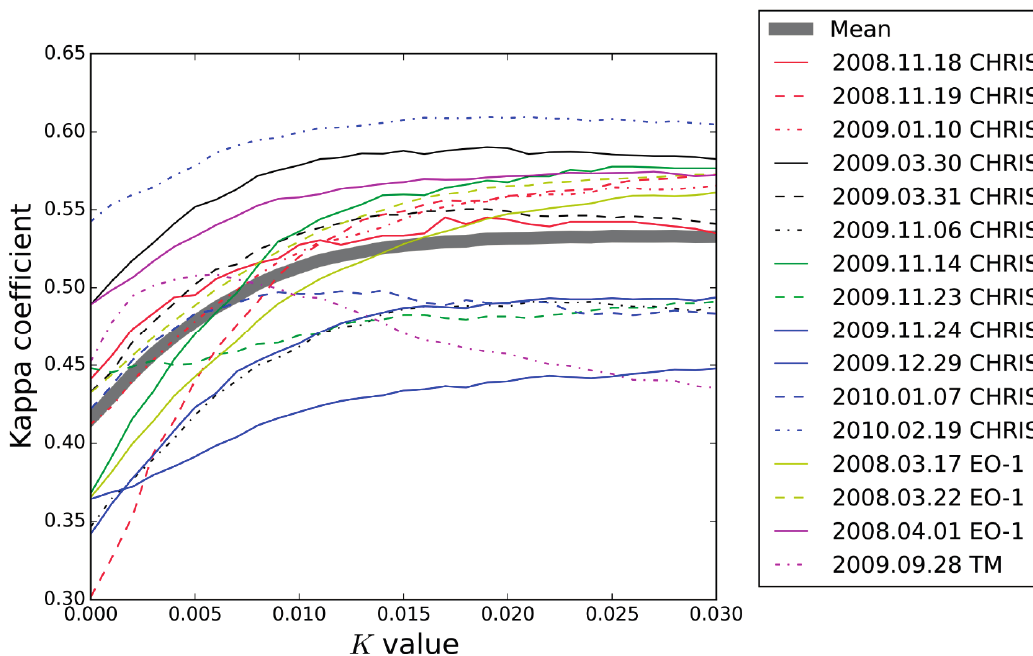
Figure 5. Kappa coefficients for the downscaled snow maps with different K values. High-resolution satellite images are used as the ground truth. It indicates similar trends of Kappa coefficients with increased K value between different calibration